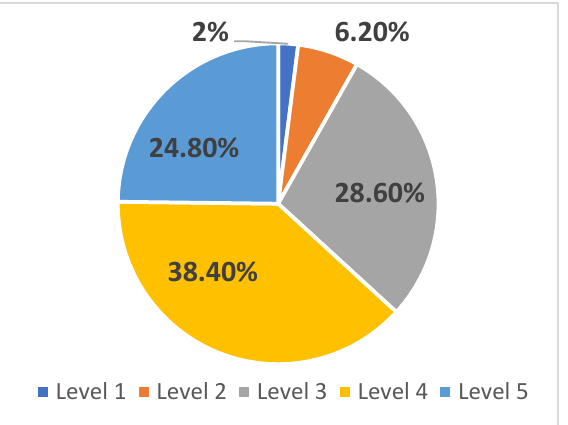
Figure 2. Oil occurrence level distribution for the marginal resource in the studied oilfield.